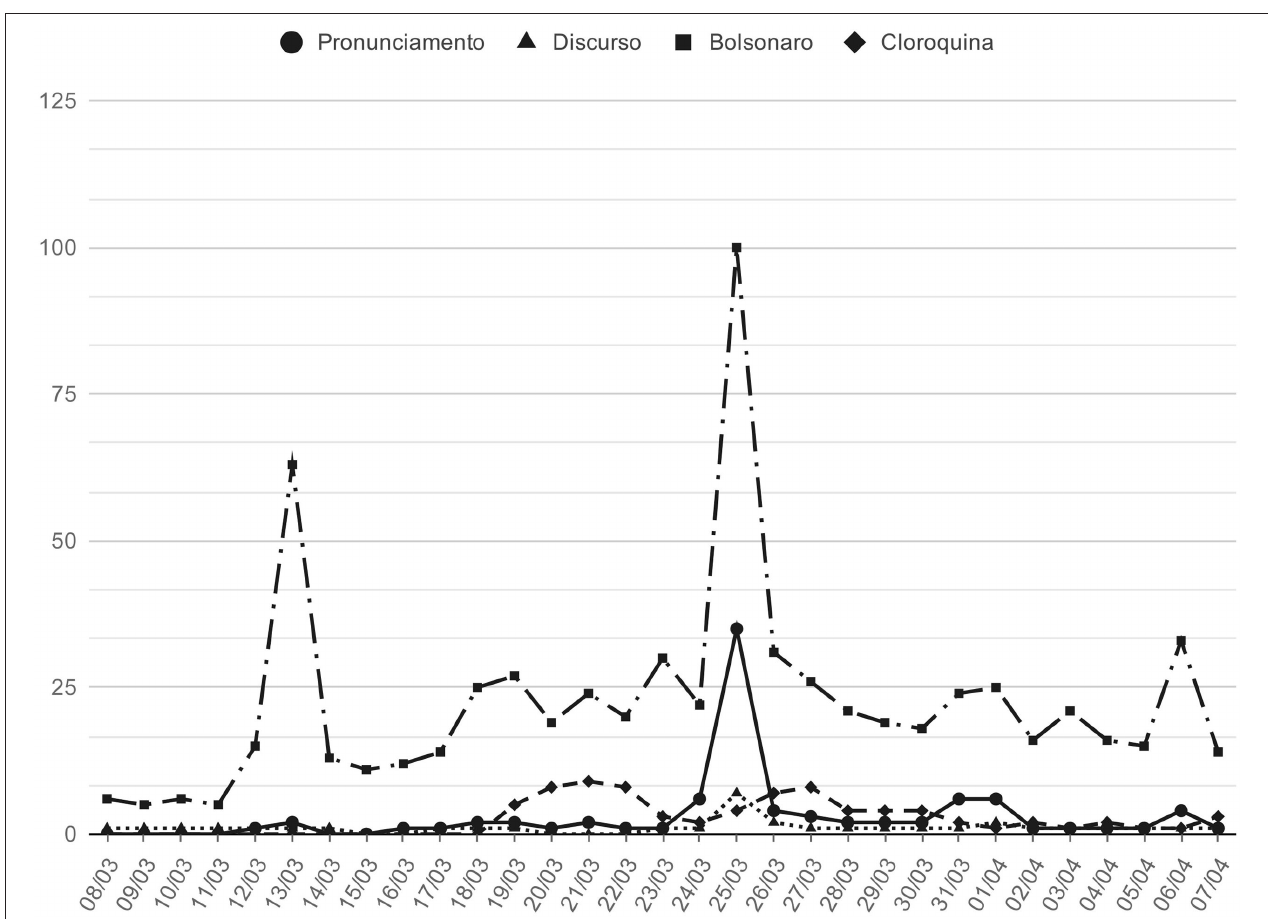
FIGURE 2 | Web Search for “Pronouncement,” “Discourse,” “Bolsonaro,” and “Chloroquine” (in Portuguese) between 3/8/20 and 4/7/20. Google trends impact: